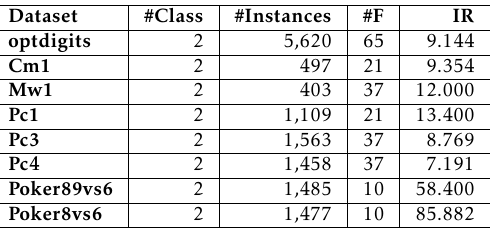
Table 5. Characteristics of Used Datasets from Other Fields